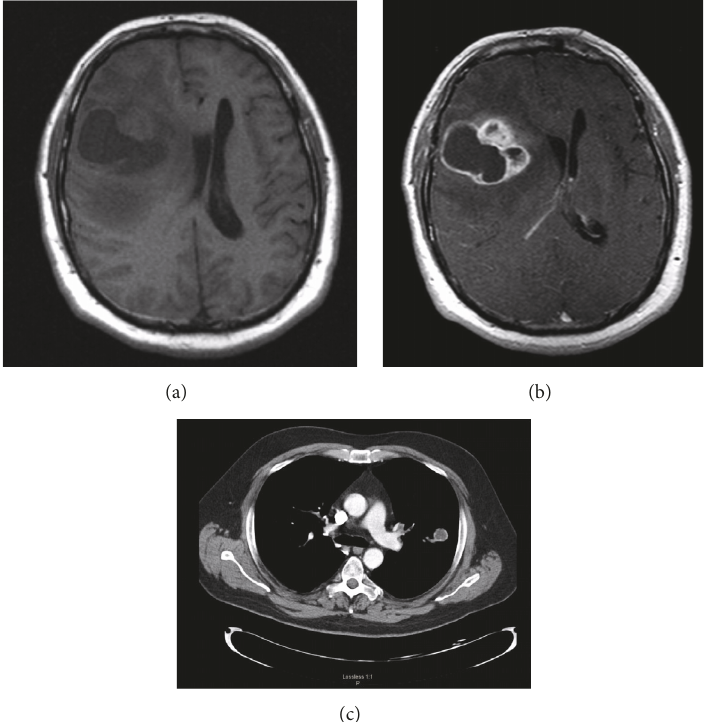
Figure 1: (a) and (b): pre- and postcontrast MRI demonstrating large right frontal ring-enhancing mass, October 2008. (c) Chest CT with mass in the left lung, May